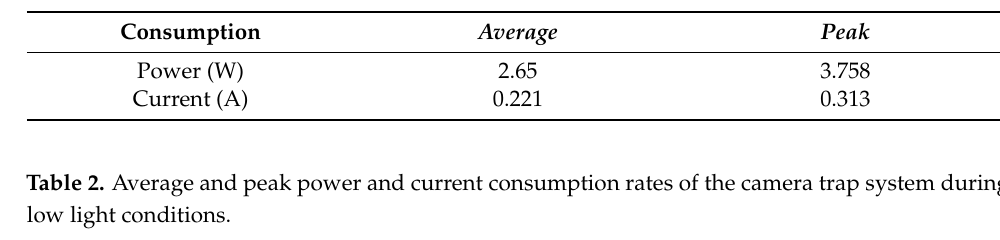
Table 1. Average and peak power and current consumption rates of the camera trap system during good light conditions.